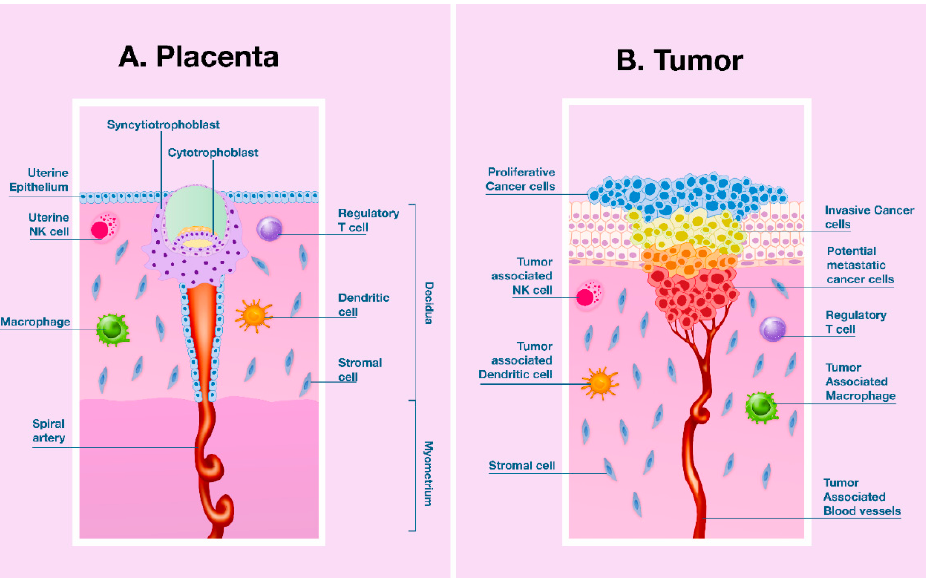
Figure 1. Human placentation and malignancy share proliferative and invasive features to establish a nutrient supply and evade or modify the host’s immune response. ( A ) Human placenta development. In the early stage of implantation, the blastocyst displays an invasive phenotype that allows implanting inside the endometrial stroma. In this process cytokines, growth factors, hormones, extracellular matrix metalloproteinases (MMPs), and immune cells, all modulate cell invasion of maternal decidua and myometrium and their capacity to transform spiral arteries. Among growth factors, placental growth factor (PlGF) secreted by the decidua, trophoblast, and uterine natural killer (uNK) cells have a determinant role in regulating invasion, vascular development, and maternal immune tolerance mechanisms to semi-allogeneic fetus; ( B ) Tumor invasion and progression. Malignancy is able to create both a vascular network that warrants perfusion of tumor mass and an immunosuppressive microenvironment by recruiting specific immune cells. Molecules (cytokines, growth factors, extracellular MMPs), produced by tumor and inflammatory cells in the tumor microenvironment, recruit (tumor-associated) immune cells, thus, creating a tolerogenic milieu that inhibits the development of an e ffi cient immune response against cancer cells that foster tumor growth and progression. PlGF blockade reduces both neoangiogenesis and lymphangiogenesis, inhibits the M2 macrophages polarization, hinders the recruitment of tumor-associated macrophages (TAM), and decreases the recruitment of myeloid suppressor cells [23]. (Illustration inspired by Holtan et al. [21] with kind permission of Elsevier, License Number: